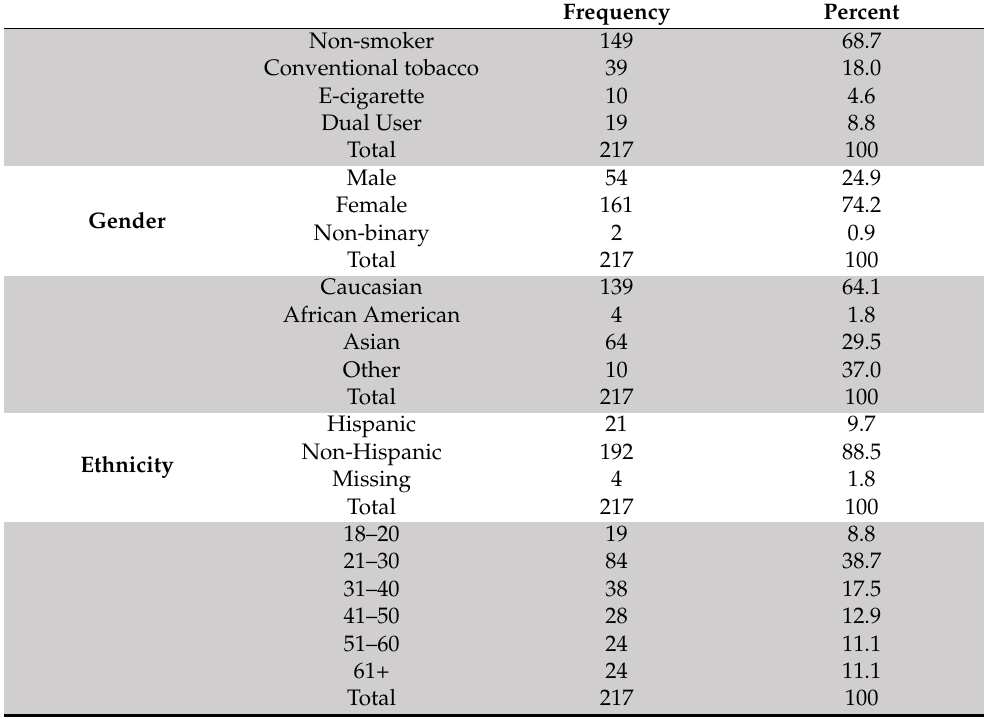
Table 1. Survey Participant